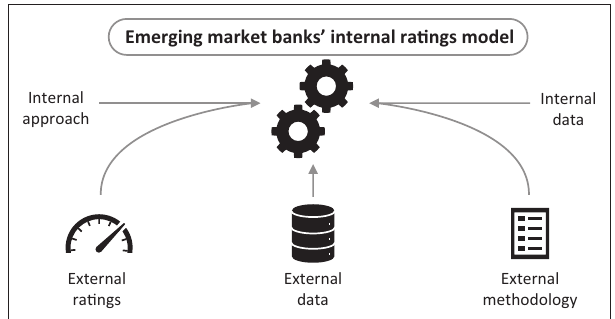
FIGURE 3: Summary of recommended ‘local ratings’ approach.